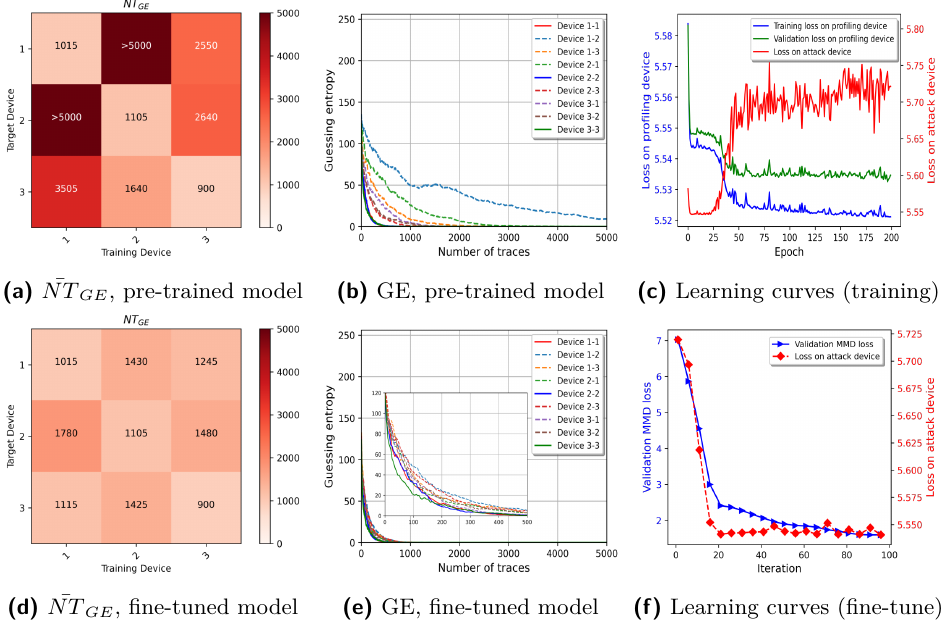
Figure 11: Results on